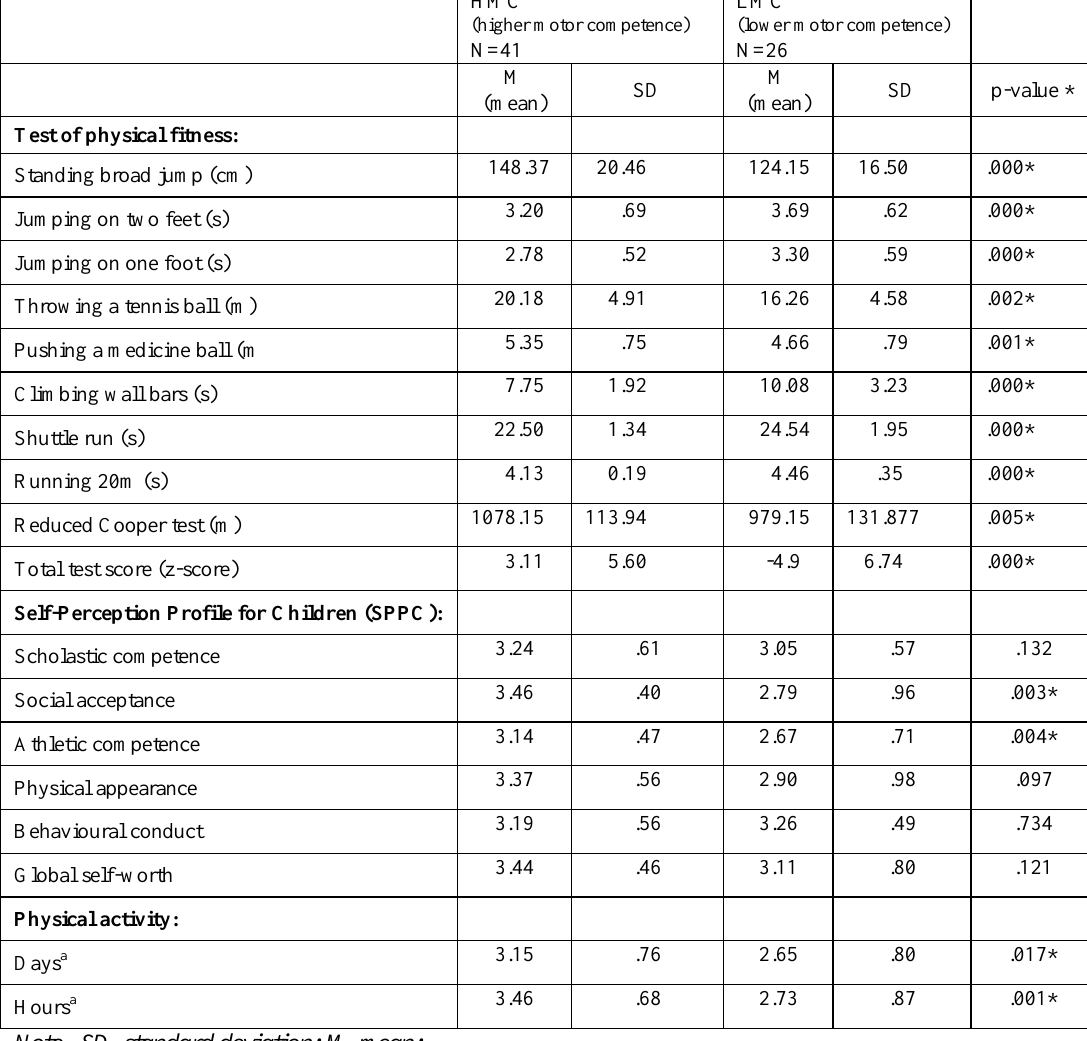
Table 4. Mean (SD) score for TPF, SPPC and PA for the two groups: HMC and